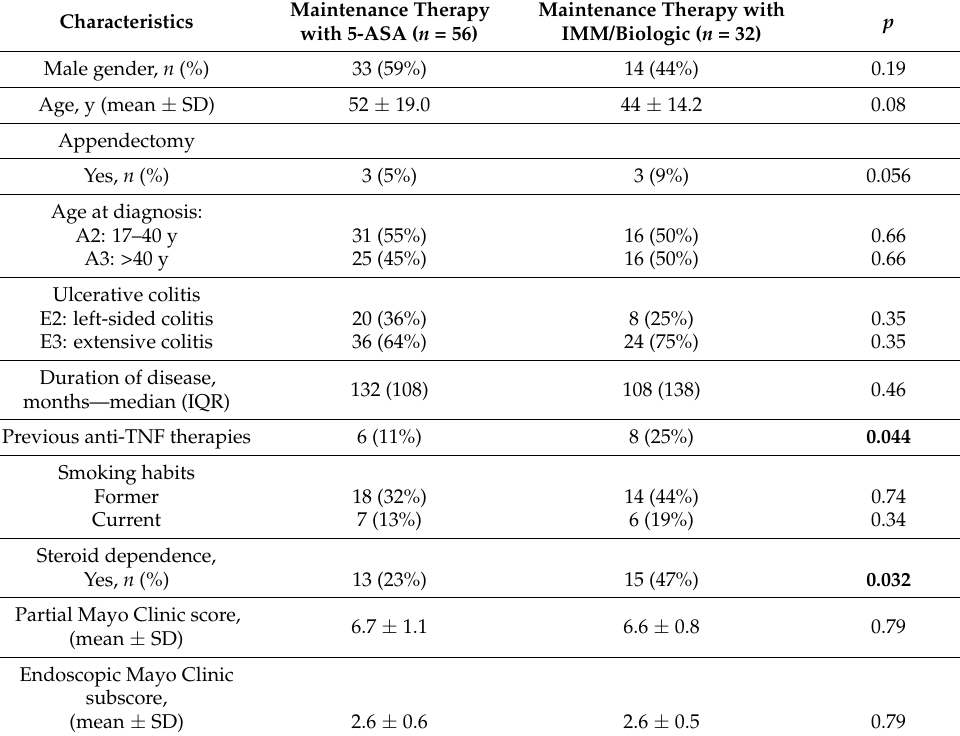
Table 1. Demographic and clinical characteristics at baseline of 88 patients with ulcerative colitis treated with intravenous corticosteroids. Patients were divided into 2 groups according to the maintenance therapy. 5-ASA = 5-aminosalycilic acid; IMM = immunosuppressor. Significant value is in